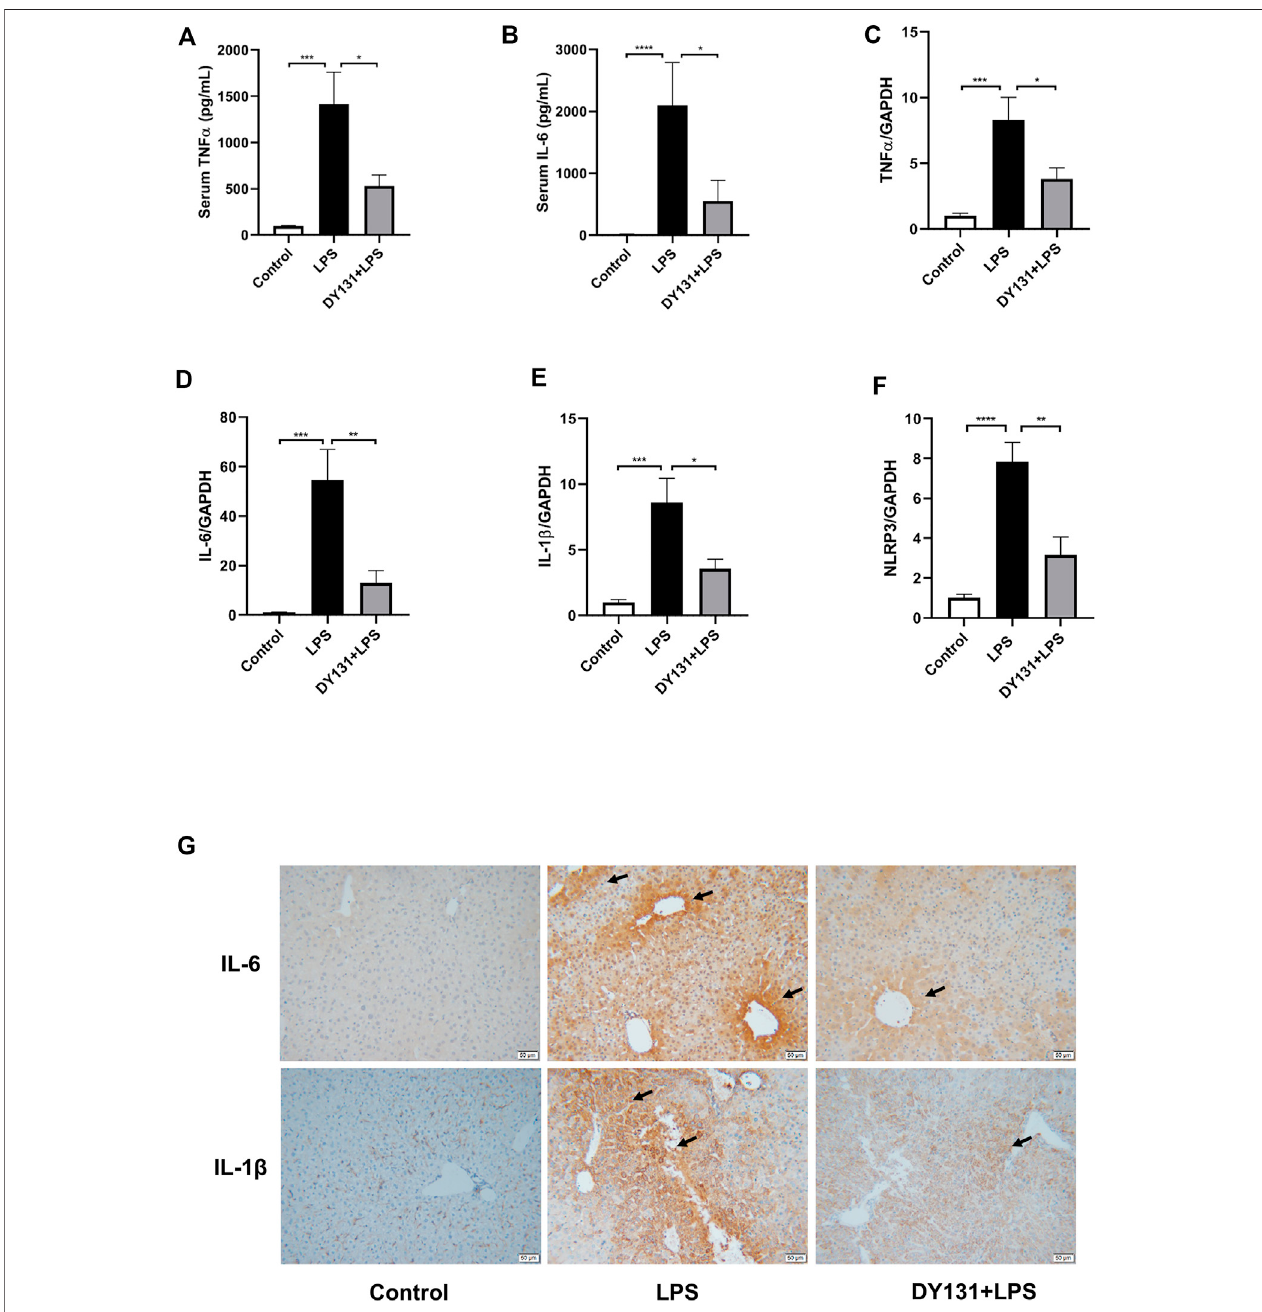
FIGURE 4 | DY131 alleviated the in fl ammatory responsein LPS-treated mice . (A,B) Serum levels of TNF α and IL-6 measured by ELISAkits (n (cid:1) 10 in each group). (C – F) mRNA expressions of TNF α , IL-6, IL-1 β and NLRP3 determined by qRT-PCR(n (cid:1) 10in each group). (G) Representativeimagesofimmunohistochemical staining ofIL-6andIL-1 β inlivertissues (magni fi cation × 200,scalebar:50 μ m,n (cid:1) 4-5ineachgroup). Datawerepresentedasmeans ± SEM.* p < 0.05,** p < 0.01,*** p < 0.001, and **** p < 0.0001 vs. the indicated